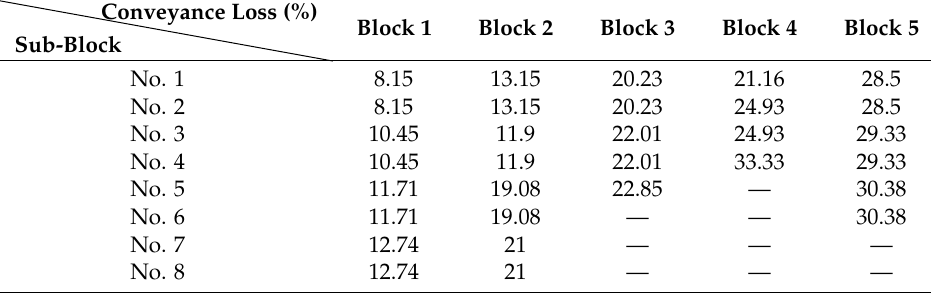
Table 2. Water conveyance loss calculation from the intake gate to each sub-block (unit: %). Sub-BlockConveyance Loss (%) Block 1 Block 2 Block 3 Block 4